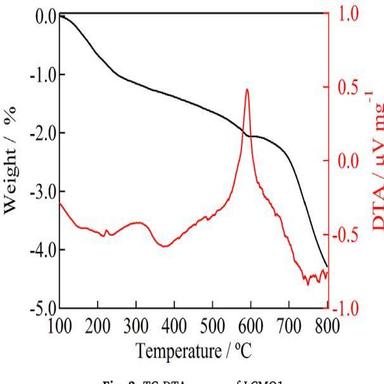
TG-DTA curves of LCMO1.